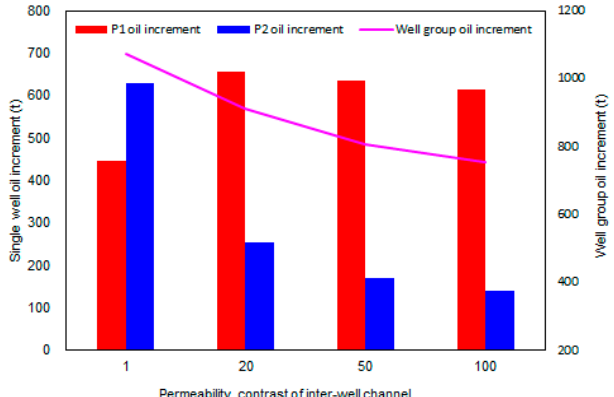
Figure 12. Oil increment with different permeability contras of inter-well channel.